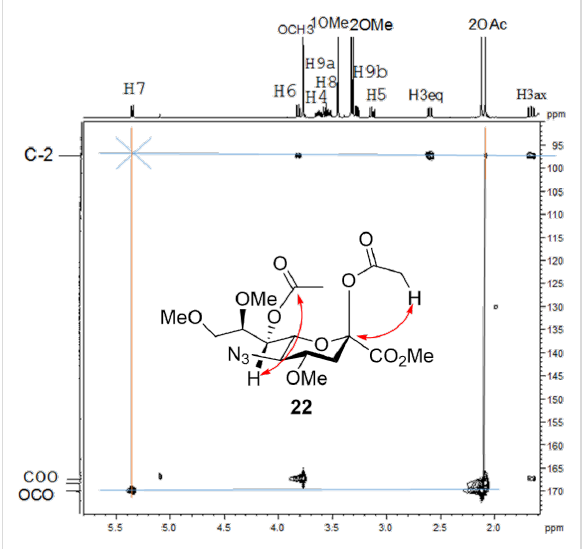
Figure 3: HMBC spectrum of carbohydrate 22